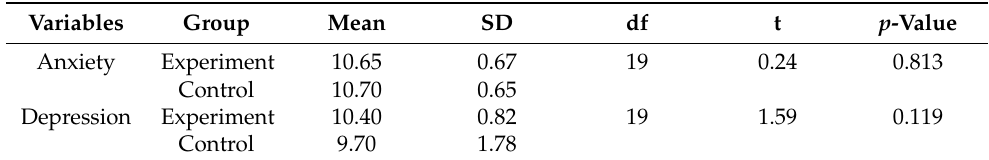
Table 3. Comparison of anxiety and depression scores at baseline between experimental and control groups (N = 40).